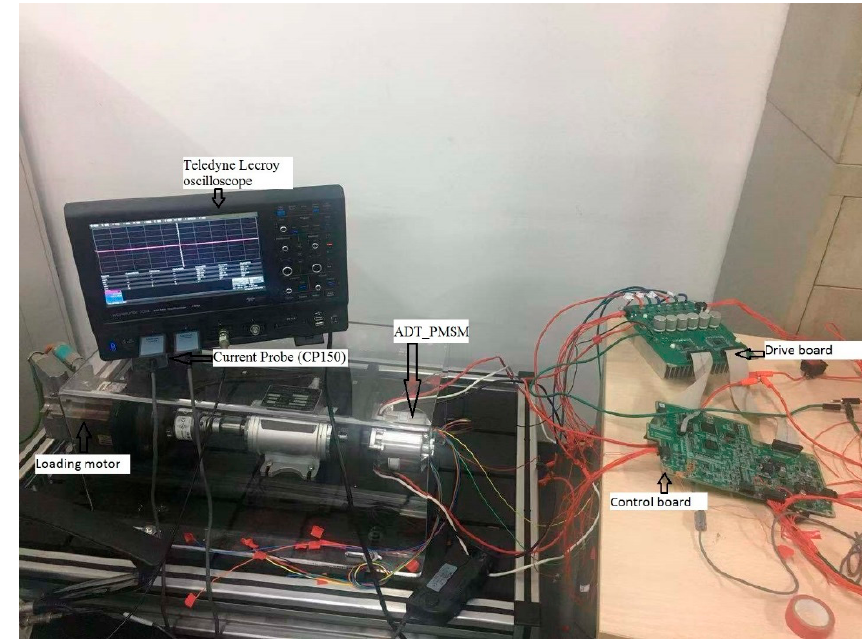
Figure 12. Experimental platform for ADT-PMSM.